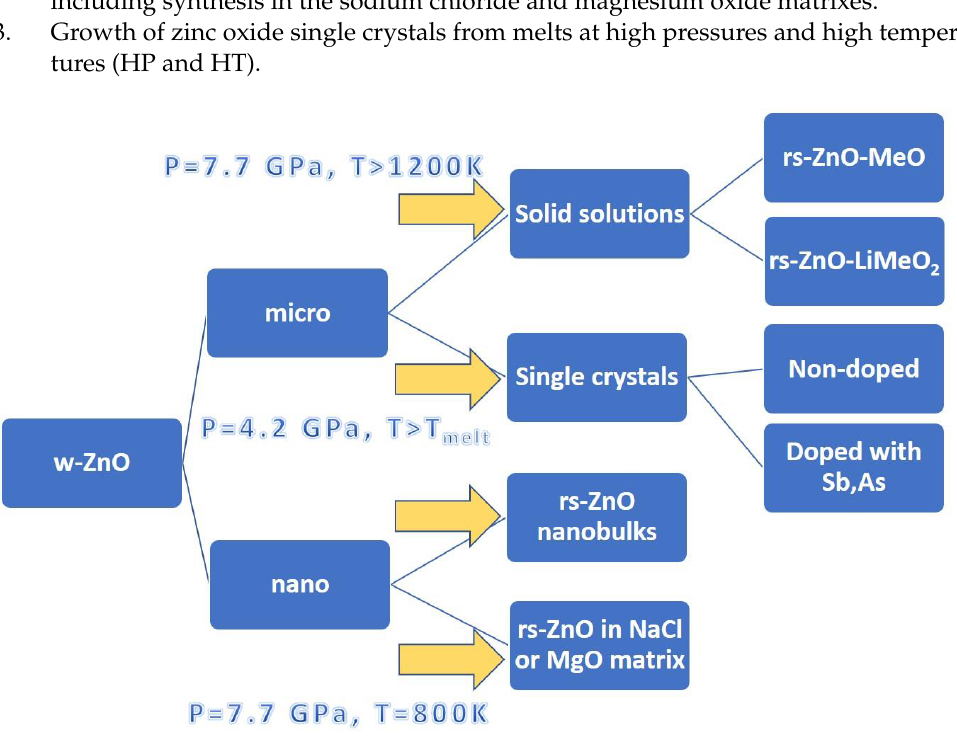
Figure 1. The scheme of high-pressure production of new phases, morphological forms and solid solutions based on zinc